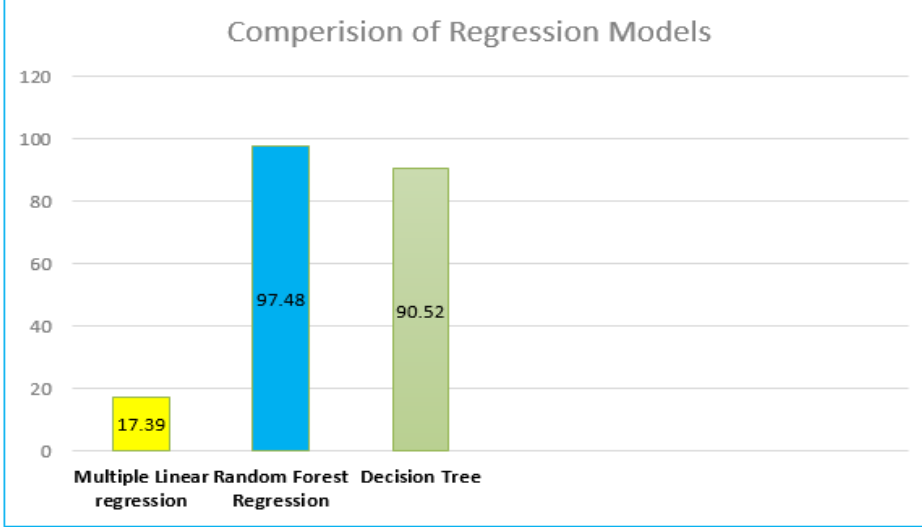
Figure 16. Parametric Analysis. Parametric Charts highlighted the comparisons of parameters of regression models. The highest performance in terms of R2 and RMSE is the Random Forest Regressor. In addition, a comparison of regressors models is presented in Table 10.